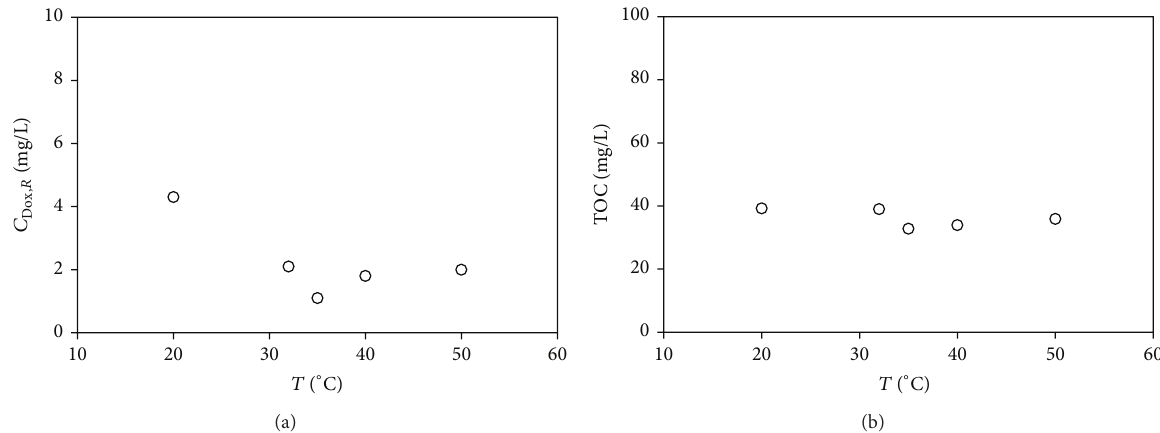
Figure 2: Influence of temperature ( 𝑇 ) on residual concentrations of (a) doxycycline ( 𝐶 of the Fenton